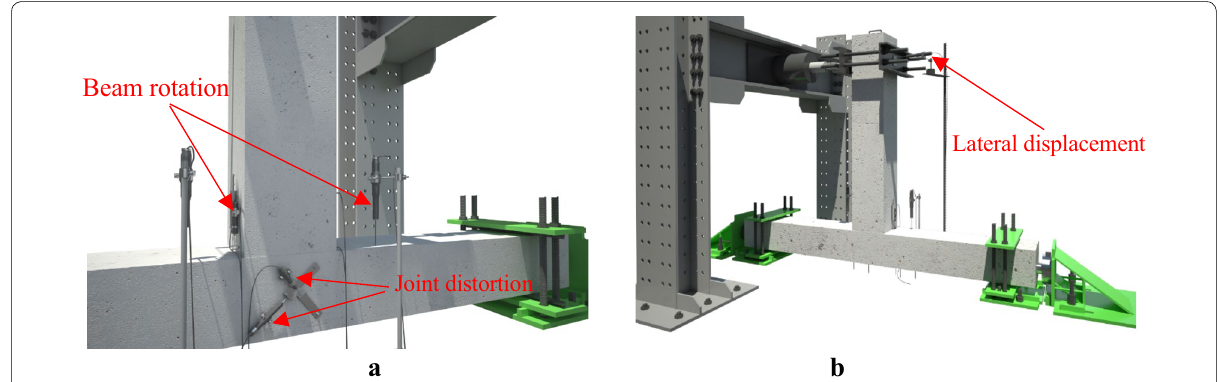
Fig. 15 Applied equipment to measure the rotation of the beam and deformation of the joint: a beam rotation and Joint distortion. b Lateral displacement of the beam-column